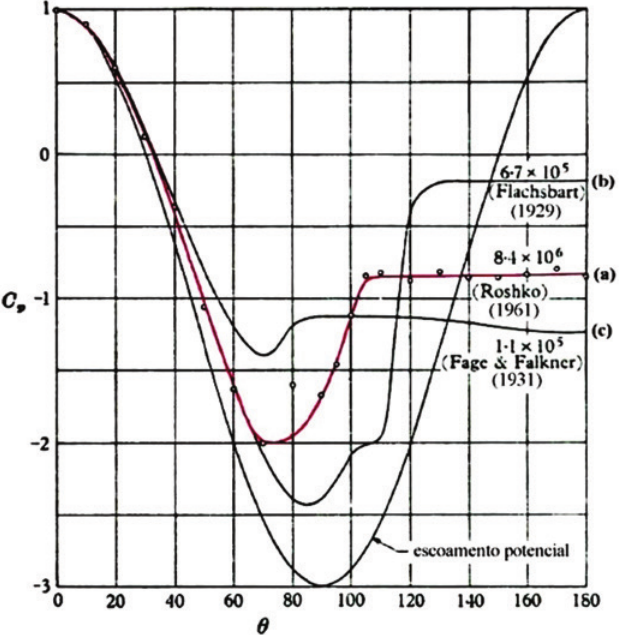
Figure 2 Circumferential distribution of pressure coefficients in circular cylinders (Roshko